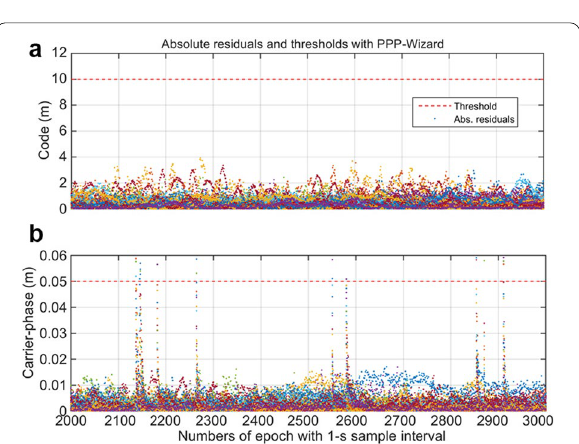
Fig. 3 Fault detection tests, i.e. checking if the absolute post‑fit residuals are less than empirical thresholds, for code and carrier‑phase measurements with PPP‑Wizard; the fault detection test was preformed group by group for different signals and